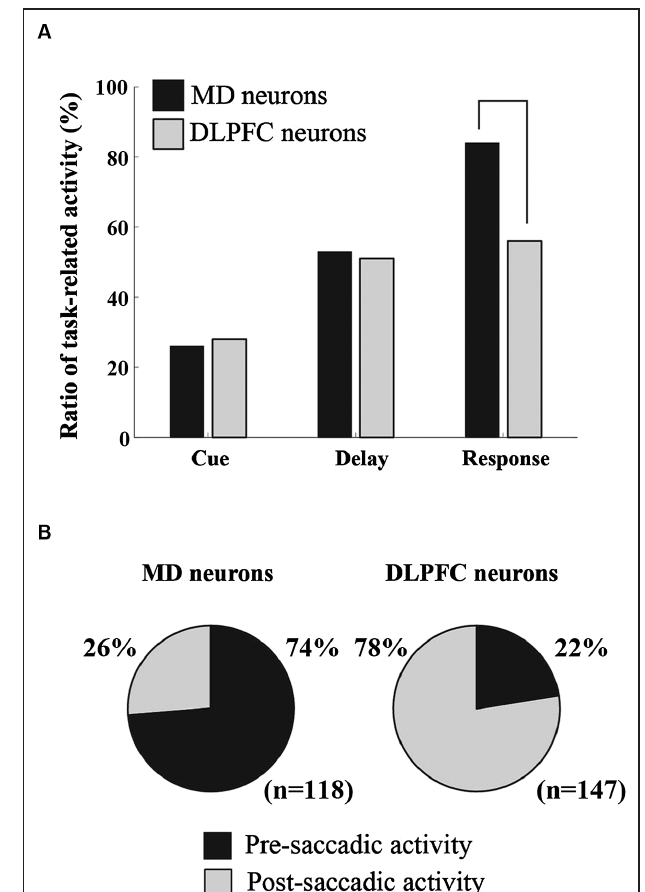
FIGURE 2 | Comparison of the characteristics of task-related activity between MD neurons and DLPFC neurons. (A) A comparison of the proportion of task-related activity between the MD and DLPFC. (B) A comparison of the proportion of pre- and post-saccadic activity between the MD and DLPFC. The data regarding DLPFC neurons and MD neurons are based on data obtained by Funahashi et al. (1989, 1990, 1991) and Watanabe and Funahashi (2004a),